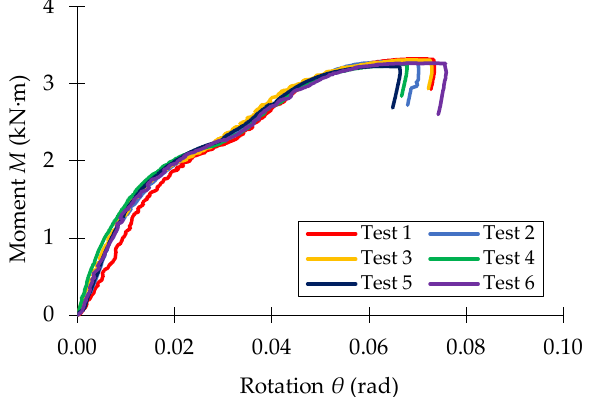
Figure 10. Moment-rotation curve ( M − θ ) recorded in bending tests for the beam-connector-upright assembly of type 0-I-5T.